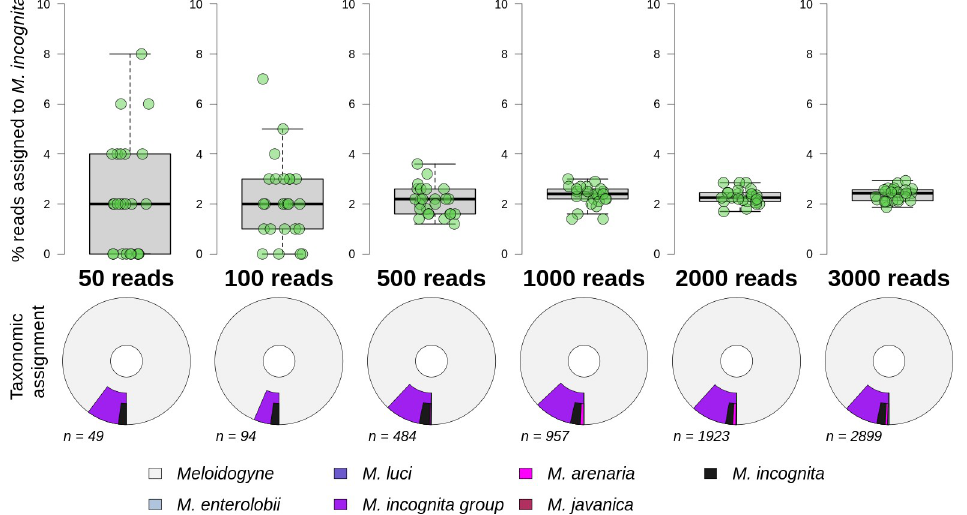
Fig 3. Taxonomic assignment success of M . incognita reads varied by read count. Top panel shows the percentage of reads assigned to species level from 50 to 3000 reads. Each treatment has 25 replicates. Lower panel shows a single replicate example of taxonomic assignment of reads ( n ) to the genus Meloidogyne and lower taxonomic levels. For each chart the distance from the inner circle represents NCBI taxonomic lineage length; the inner segment is genus level assignment, the second segments are species level assignments (including the MIG species group). MIG species populate the outermost segments, internal to the MIG species group assignments. Segment widths denote proportion reads assigned to that taxonomic level or species.